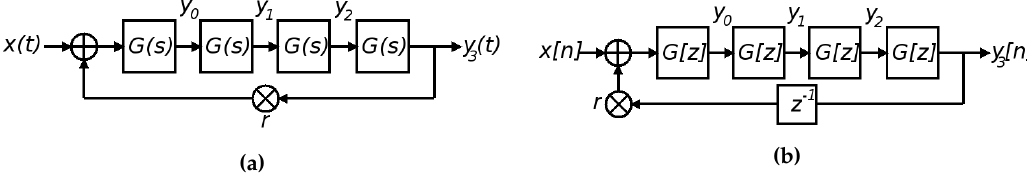
Figure 1. Continuous-time ( a ) and discrete time ( b ) block diagrams of the Moog ladder filter after Stilson and Smith, 1996